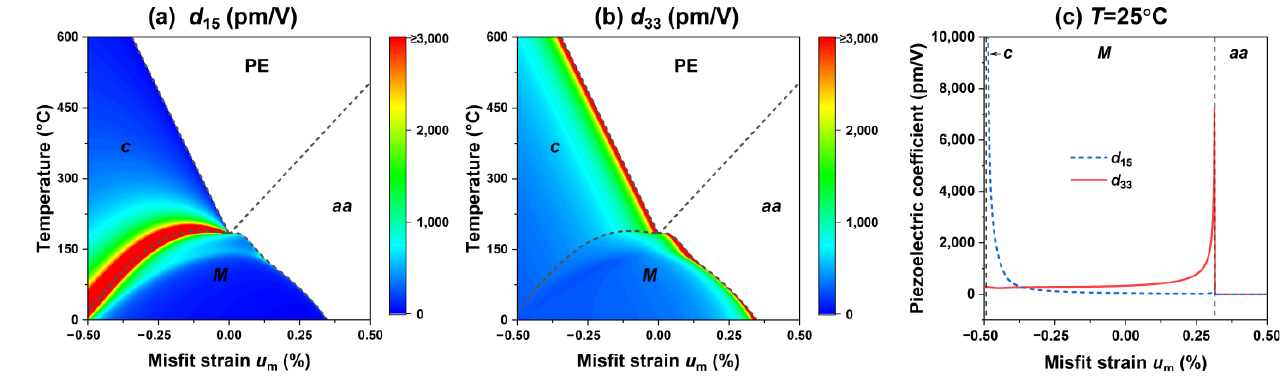
Figure 3. The piezoelectric coefficients ( a ) d 15 , and ( b ) d 33 as a function of misfit strain and temperature. Materials 2022 , 15 , x FOR PEER REVIEW ( c ) The corresponding piezoelectric coefficients as function of misfit strain u m at room temperature.